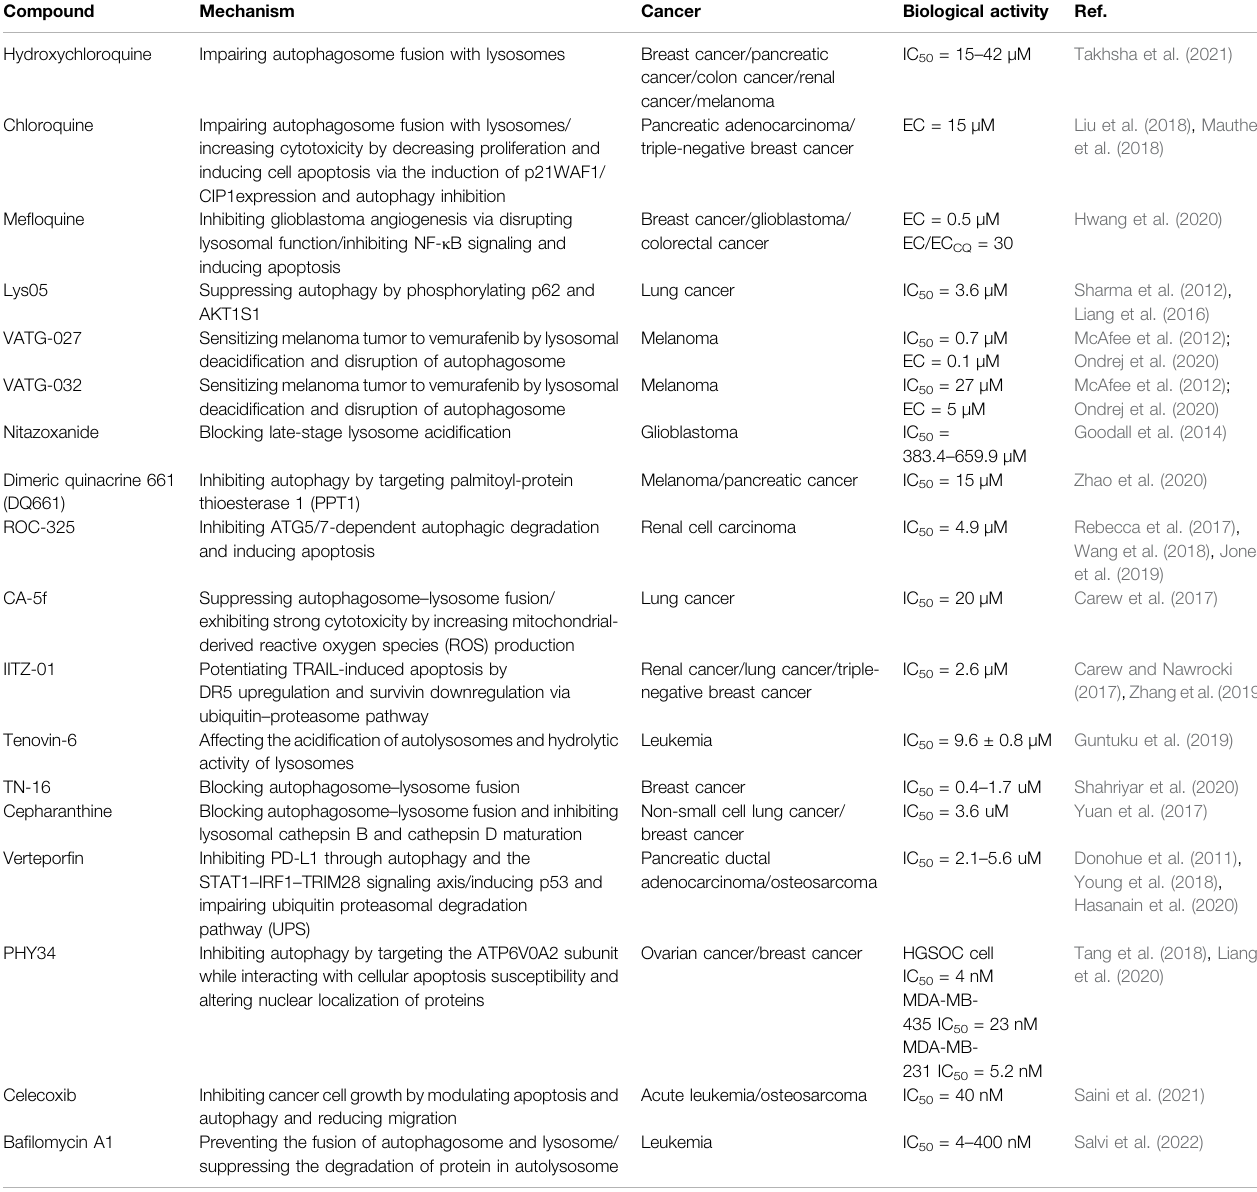
TABLE 2 | Other small-molecule compounds for inhibiting autophagy in cancer